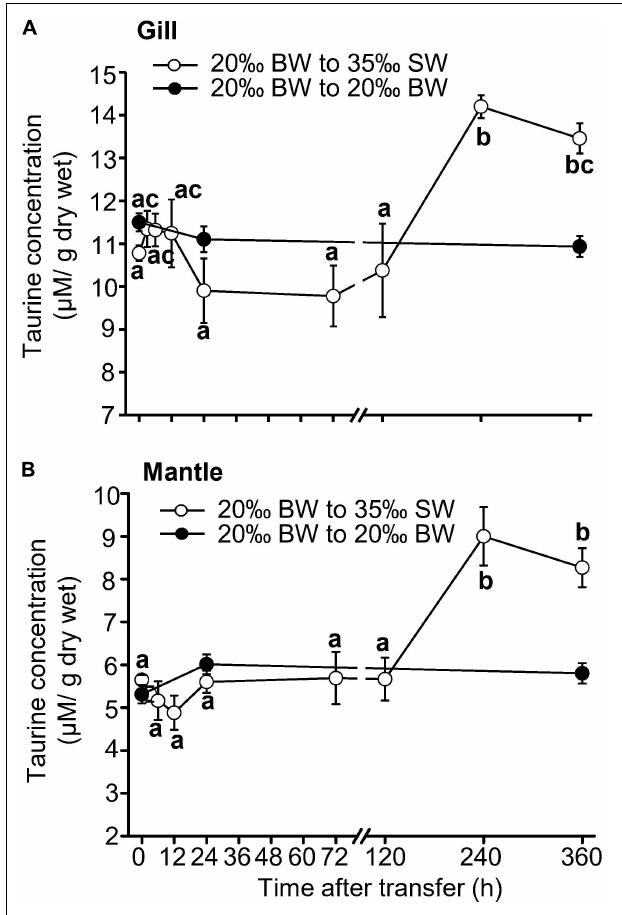
brackish water (BW) to 35 (cid:104) (cid:104) seawater (SW). Different letters indicate significant differences between BW). Values are the (cid:104)